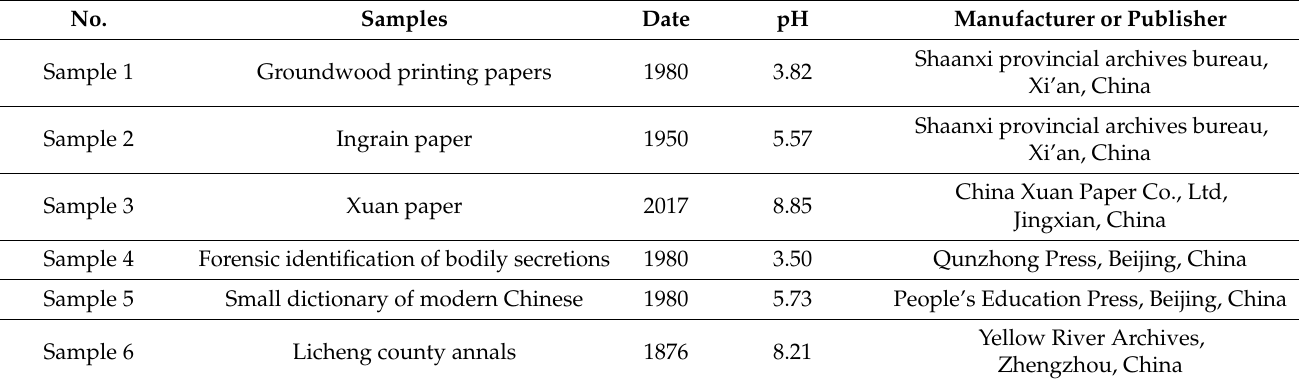
Table 1. Selected paper samples used in this study.